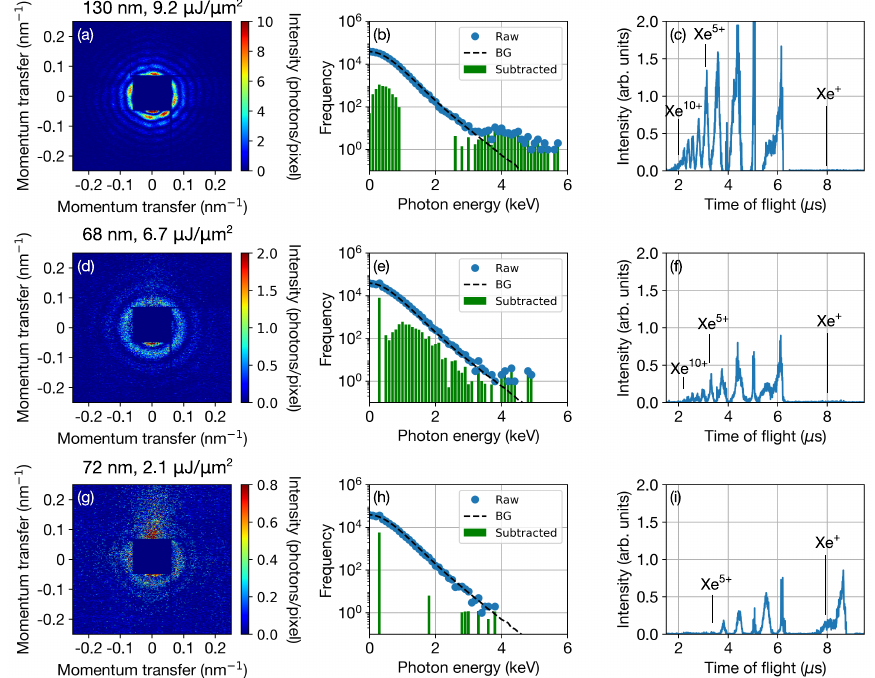
Figure 2. Characteristic results of the multispectroscopic measurements. Each diffraction image, fluorescence spectrum, and ion TOF spectrum shown in ( a – c ), ( d – f ), and ( g – i ) are observed from Xe clusters with the radii of cluster and the fluence ( r 0 , J 0 ) of (130 nm, 9.2 µ J/ µ m 2 ), (68 nm, 6.7 µ J/ µ m 2 ), and (72 nm, 2.1 µ J/ µ m 2 ), respectively. Scattered intensity was observed in the upper region of the diffraction images ( a , d , g ), which came from the parasitic scattering of the XFEL pulses due to the configuration of the upstream optical